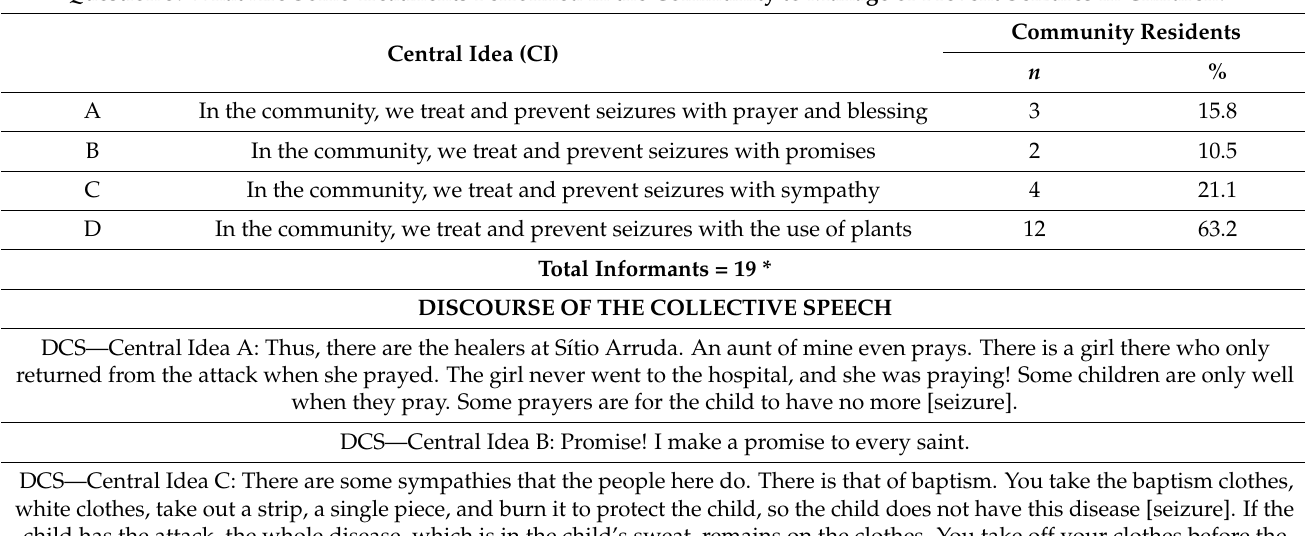
Table 3. Relationship between central idea (CI) of question 3, proportion of responses according to research participants and DCS for question